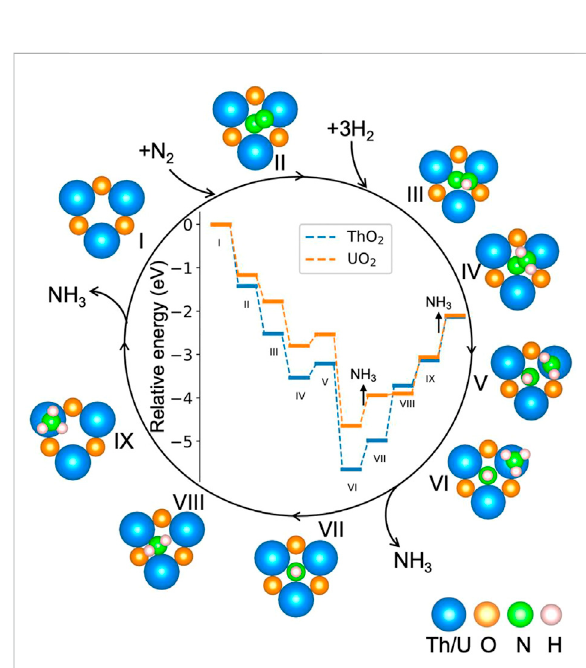
FIGURE 4 PotentialenergydiagramfortheNH 3 synthesiscycleonThO 2 and UO 2 surfaces containing oxygen vacancies. The relative energy is de fi ned by Δ E (cid:1) E Total − E sub − E N the energy of the most stable con fi guration at each reaction step, as shown in the fi gure, E sub is the energy of the ThO 2 /UO 2 surface containing the oxygen vacancy, and E N energies of the N 2 and H 2 gas phase molecules, respectively.